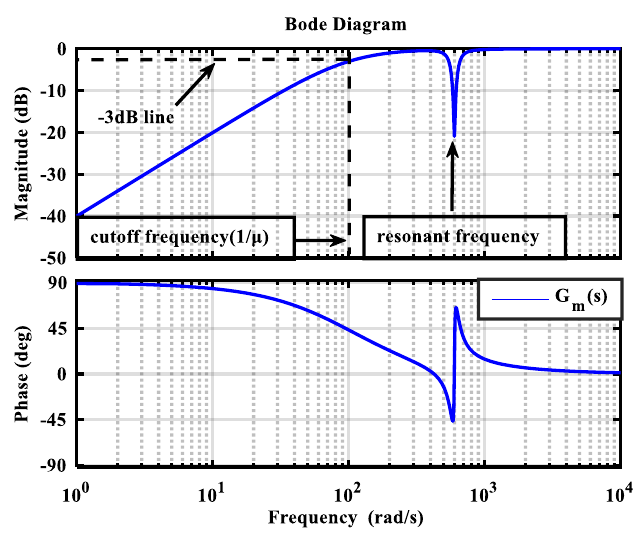
of 600 rad/s passes through the modified filter, its amplitude will be attenuated by 20 dB, 20dB, which indicates the torque ripple will be suppressed. which indicates the torque ripple will be suppressed.